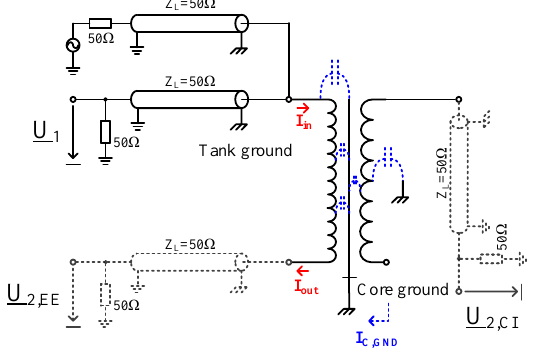
Figure 12. Connection schemes for measurements of end-to-end (EE) and capacitive inter-winding (CI) frequency response.